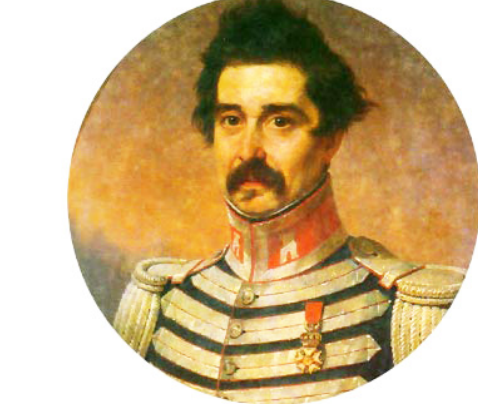
Figure 1. Portrait of Agustín Codazzi (http://www.